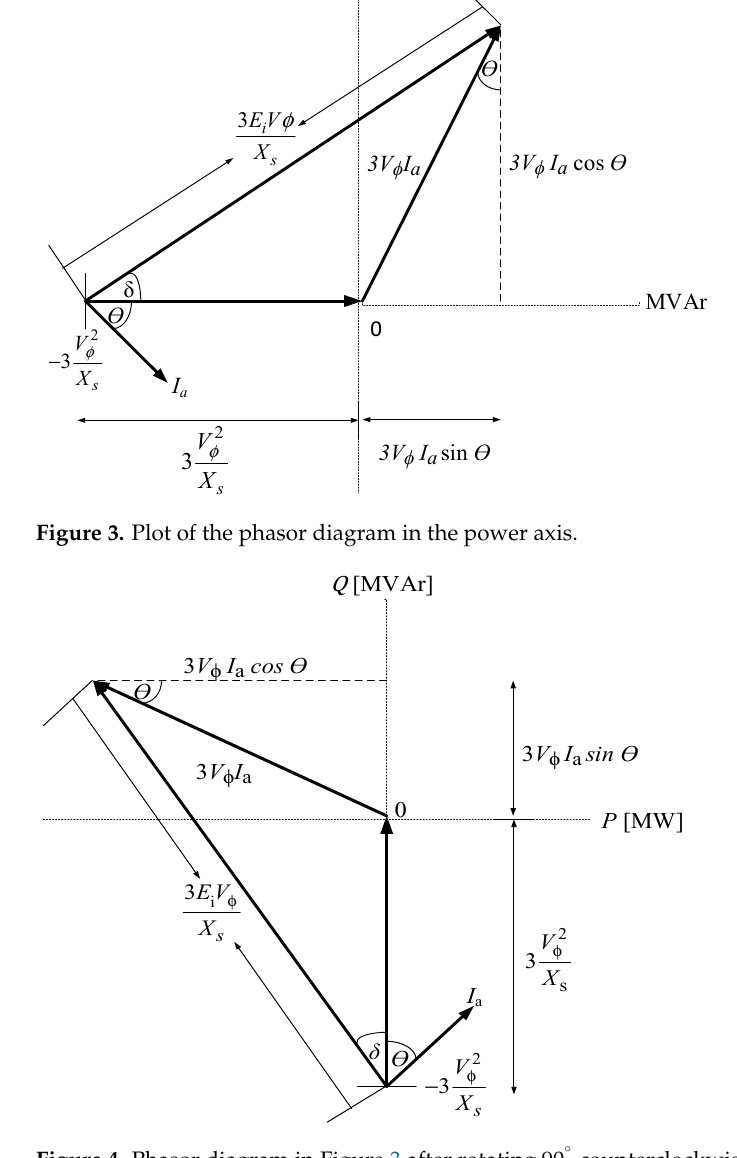
Figure 5. Phasor diagram in Figure 4 after reflecting on the 𝑦 -axis . Figure 4. Phasor diagram in Figure 3 after rotating 90 ◦ Figure 4. Phasor diagram in Figure 3 after rotating 90 ° counterclockwise.